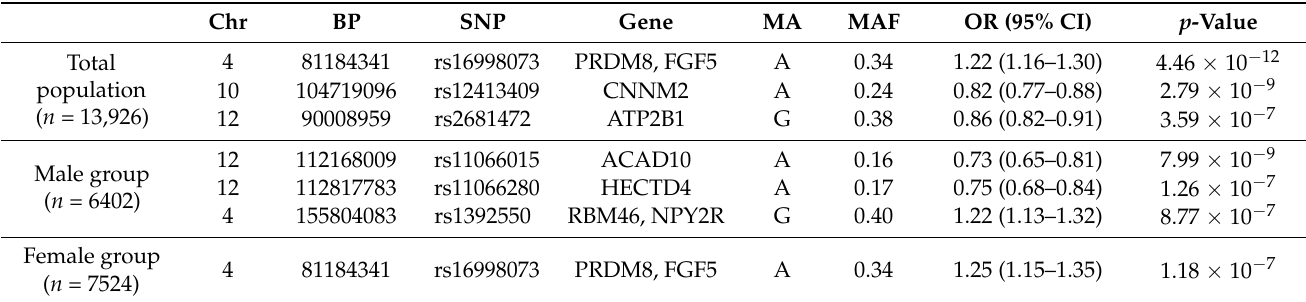
Table 1. Exome-wide association study results of hypertension in total, male, and female population.